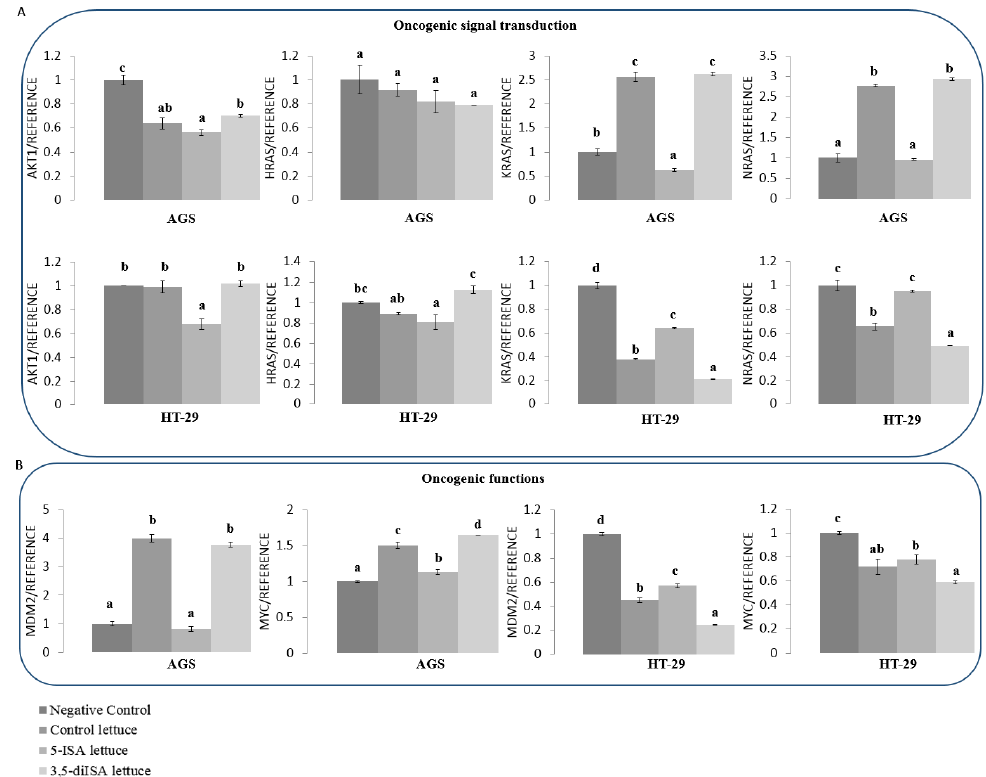
Figure 5. The effect of extracts from iodine-biofortified lettuce on mRNA expression of genes in human cancer cells of AGS and HT-29 cell lines. ( A ) Oncogenic signal transduction. ( B ) Oncogenic functions. Cells were treated for 48 h with 1000 µg/mL extract from control lettuce, or 5-ISA-fortified lettuce, or 3,5-diISA-fortified lettuce. The results are shown as means ± SD. Statistical significance was assessed using one-way ANOVA followed by Tukey’s post hoc. Columns with the same letter are not significantly different ( p > 0.05).